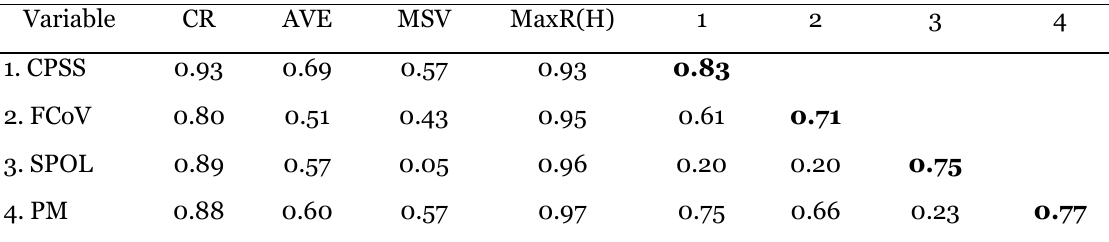
Overall Reliability and Validity of the